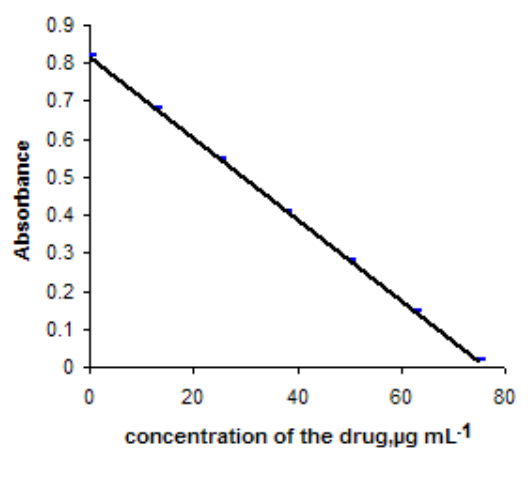
Figure 2 . Linearity curve Table 1 . Analytical and regression parameters of proposed